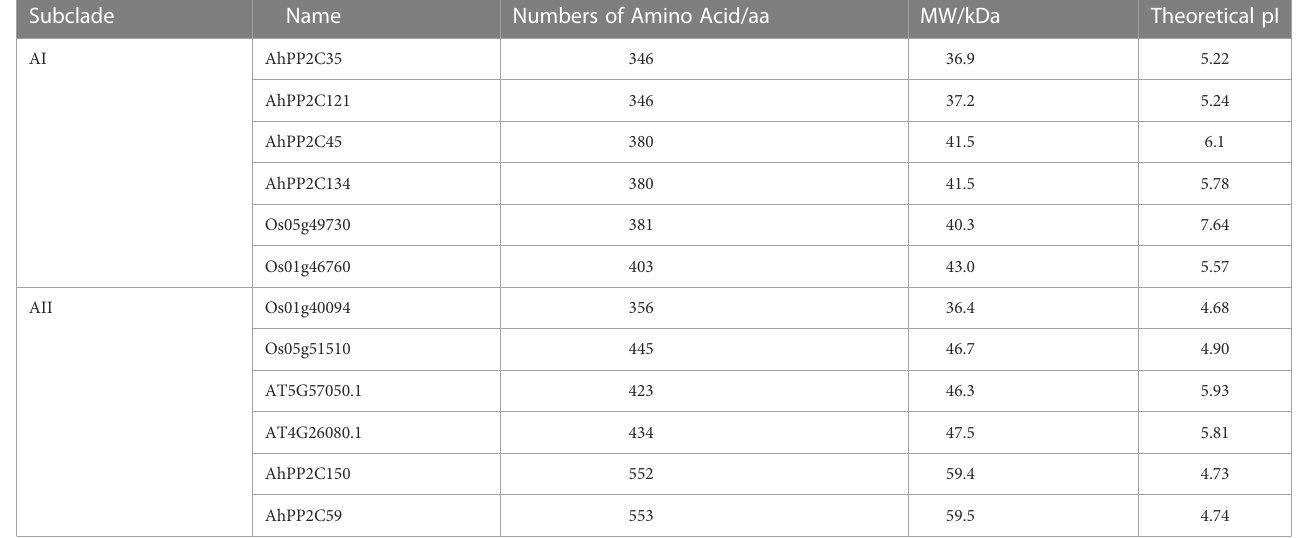
TABLE 1 Physicochemical parameter of PP2Cs in Subclades AI and AII. Subclade